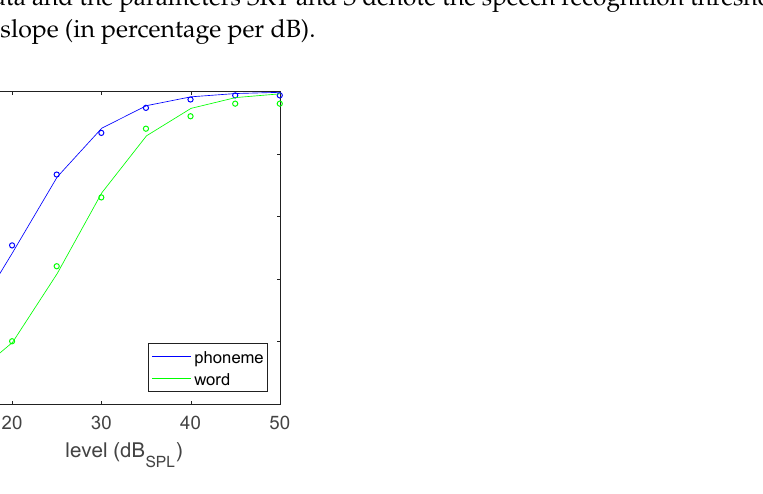
For phoneme scoring, the threshold (SRT in quiet or SRT q ) and slope values are re-